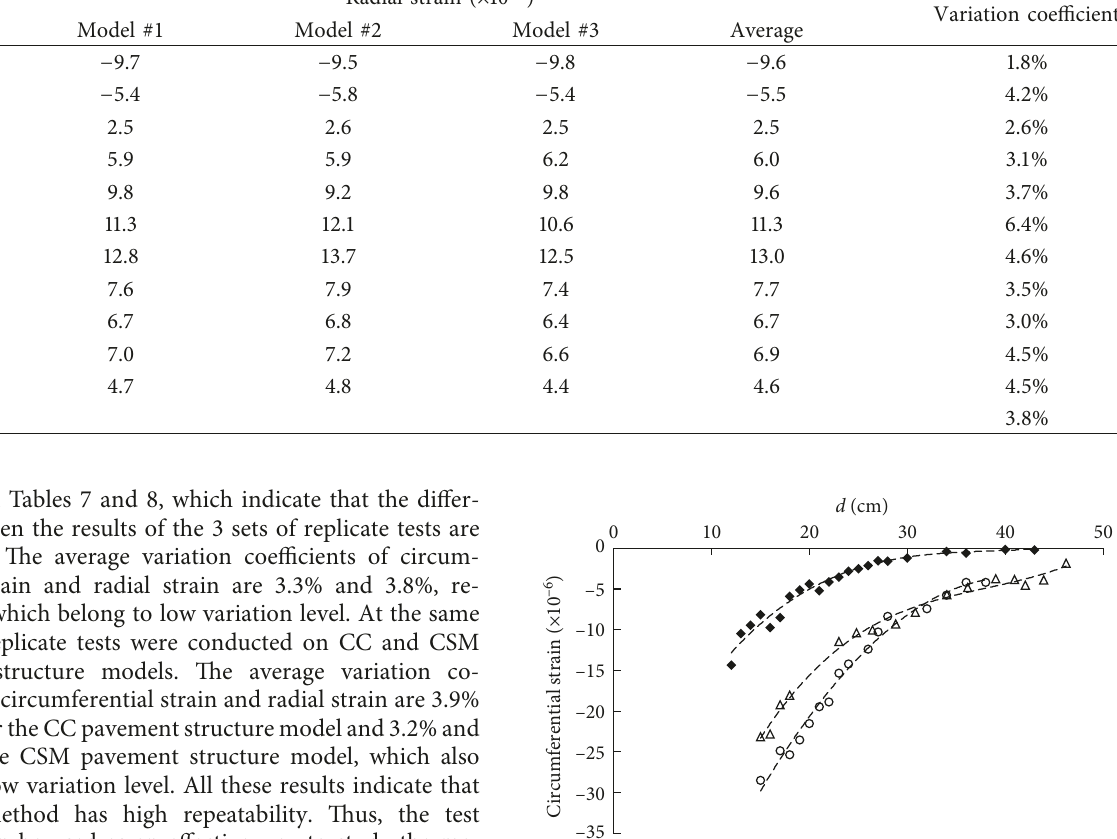
Table 8: Replicate test results of radial strain of the AC pavement structure model. d (cm)